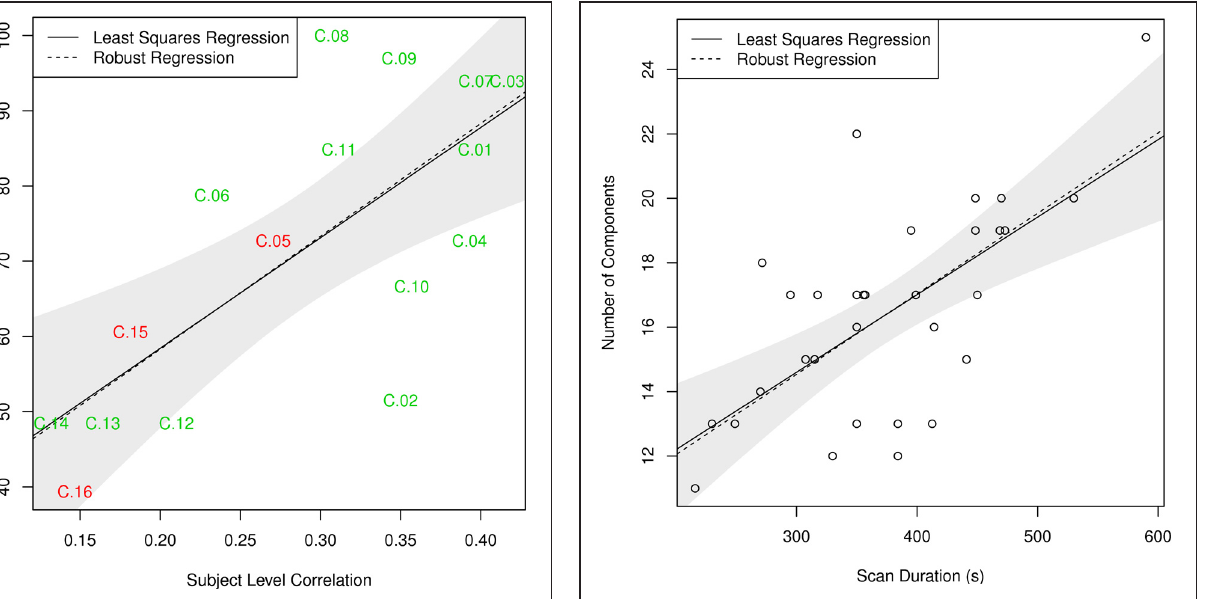
FIGURE 8 | Comparison of subject level consistency based on spatial correlation of single subject component maps with study level consistency based on identification of maps in individual-study results. Ordinary least squares (OLS; p = 0 . 002) and robust MM-estimator ( p < 10 − 4 ) illustrate the relationship between the two measures. The shaded area corresponds to a 95% confidence interval for the OLS estimator.